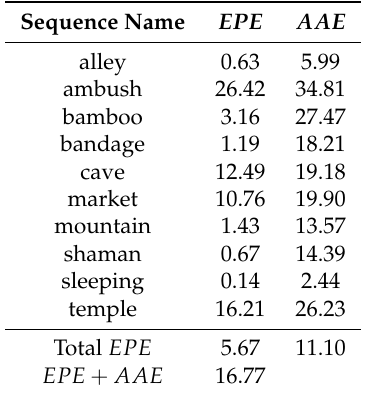
Table 16. Summary of results. The end point error and average angular error obtained by the combination of uniform and medium gradients in the MPI-Sintel training